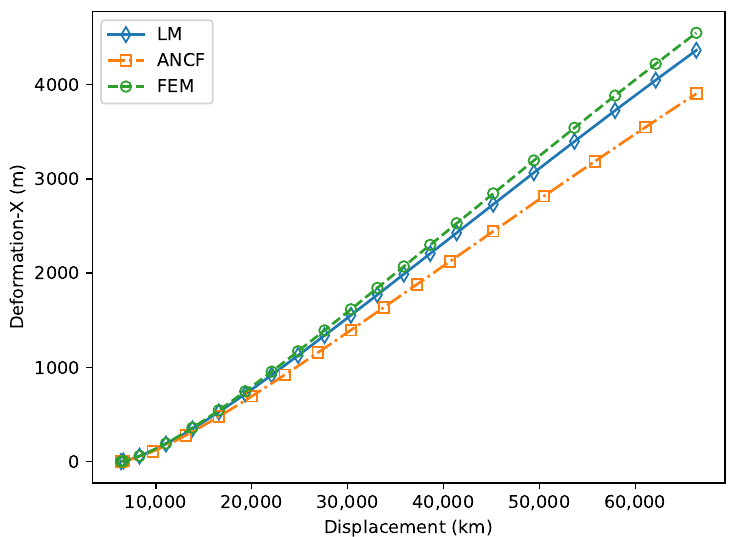
Figure 7. Deformation of x axis of three